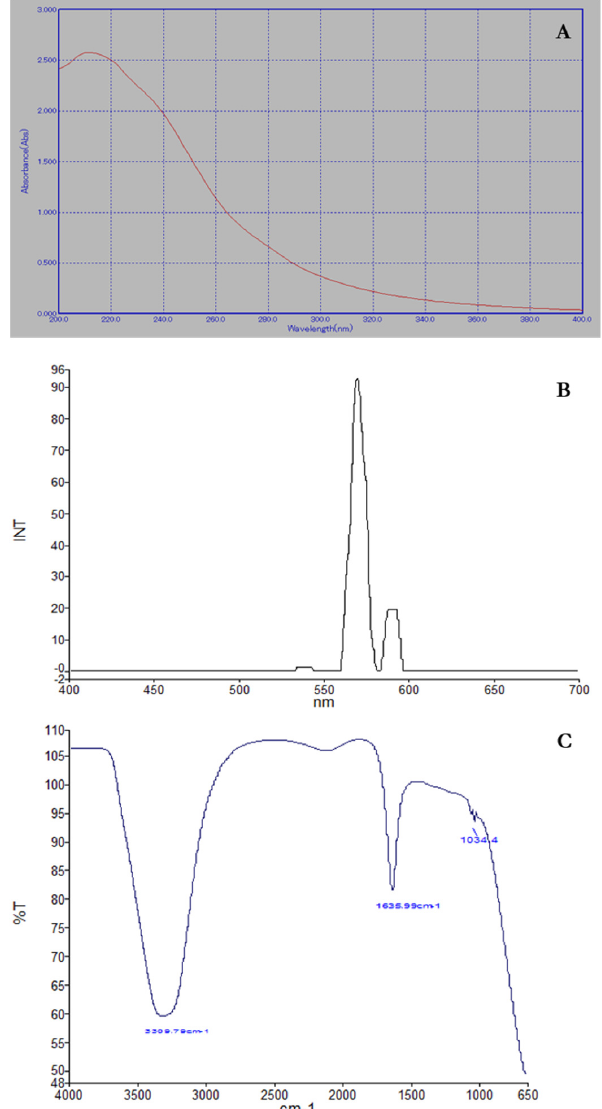
Figure 2. UV-VIS (A), Fluorescent (B) and FT-IR analysis (C) of by-product waste from